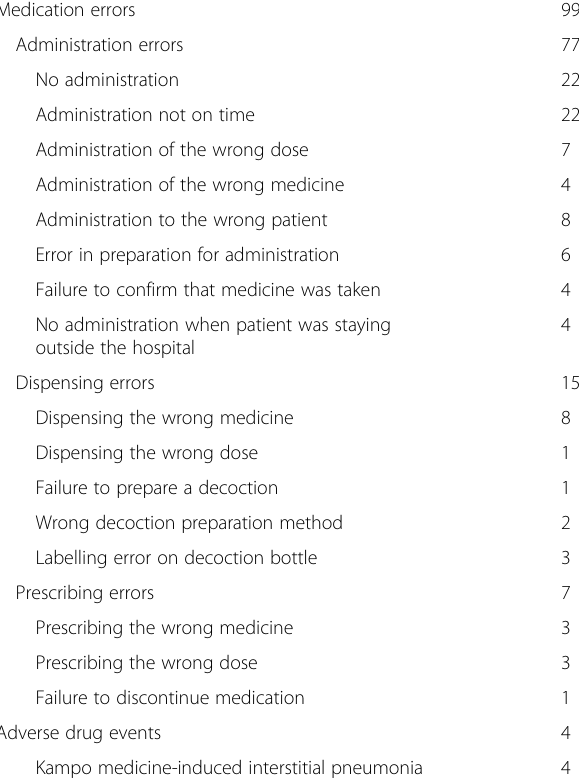
Table 3 Kampo medicine-related medication errors and adverse drug events from May 2007 – April